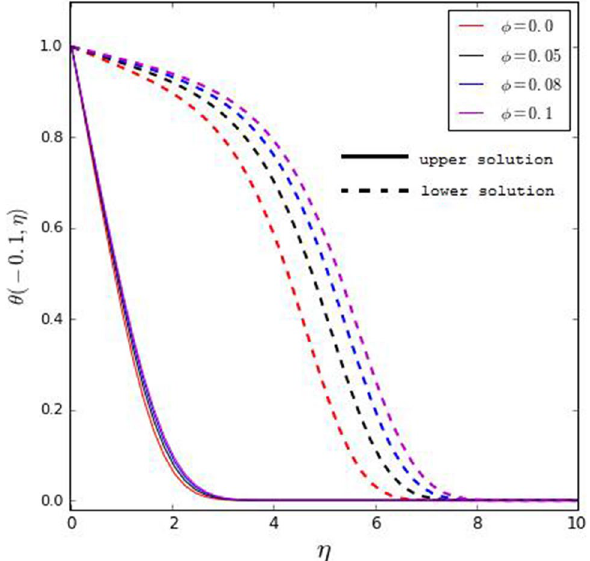
Fig. 11 Profiles for 𝜃 (− 0.15, 𝜂 ) for different 𝜙 = 0.05 for buoyancy opposing flow ( 𝜆 < 0 ) for fixed Pr =